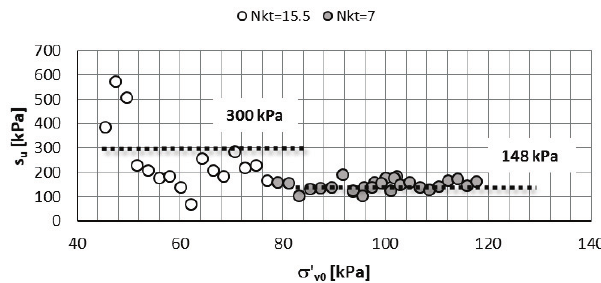
Fig. 7. A comparison of shear strength values from CPTU for recommended values of N